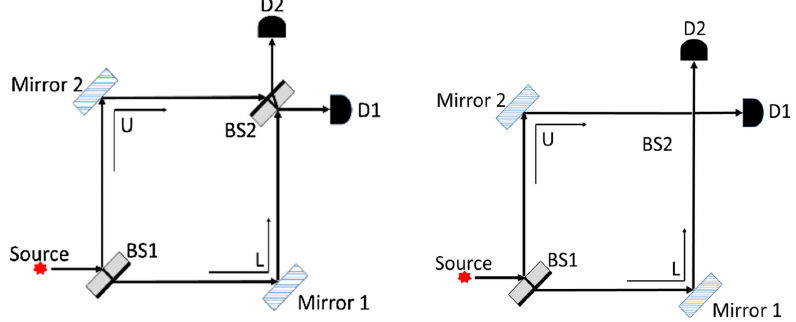
FIG. 6. MZI setup with beam splitter 2 (BS2) inserted (left) and MZI setup with beam splitter 2 (BS2) removed (right).